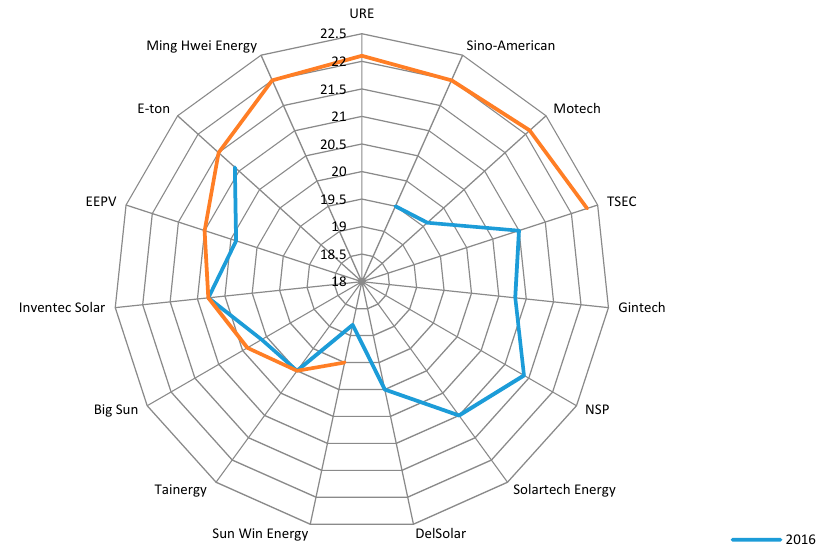
Figure 11. c-Si mono cell efficiency (%) of Taiwanese manufacturers within the period.